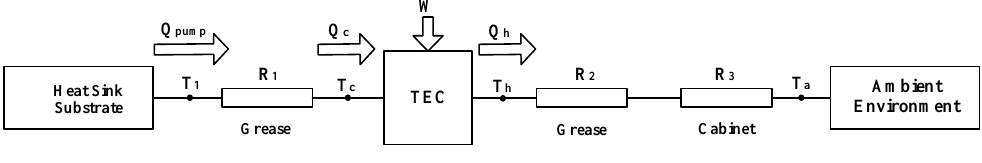
Figure 7. The thermal resistance network diagram.